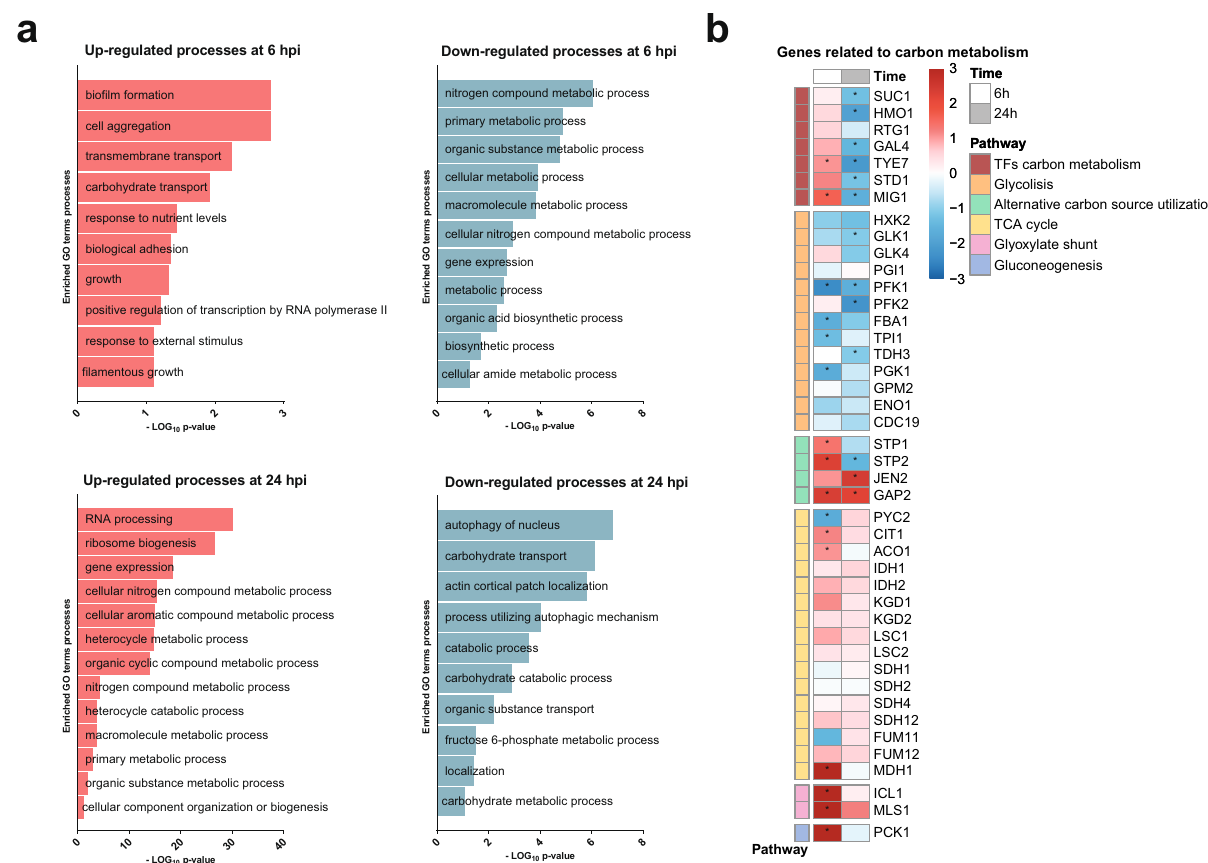
Fig. 5 C. albicans undergoes transcriptional metabolic adaptations when infecting L. rhamnosus colonized epithelium. a GO-term enrichment analysis of differentially regulated genes (Log 2 fold change >1 or < − 1 and p < 0.1) analysed with the GO-term fi nder on the Candida Genome Database website and reduced with the Revigo program (http://revigo.irb.hr/) (similarity: Tiny (0.4)). Signi fi cantly enriched GO terms are plotted based on the – Log 10 p -value from the Bonferroni-corrected hypergeometric distribution. Data summarized from n = 3 at 24 hpi. Source data are provided as a Source Data fi le. b Heatmap highlighting the transcriptional regulation of C. albicans metabolic genes as a result of L. rhamnosus colonization at 6 and 24 hpi. Legend colour represents the Log 2 fold change of the regulation in presence vs . absence of L. rhamnosus . The asterisks (*) represent signi fi cance, based on the criteria of a Log 2 fold change of >1 or < − 1 and a moderated t-test, Bonferroni-corrected two-tailed p -value of